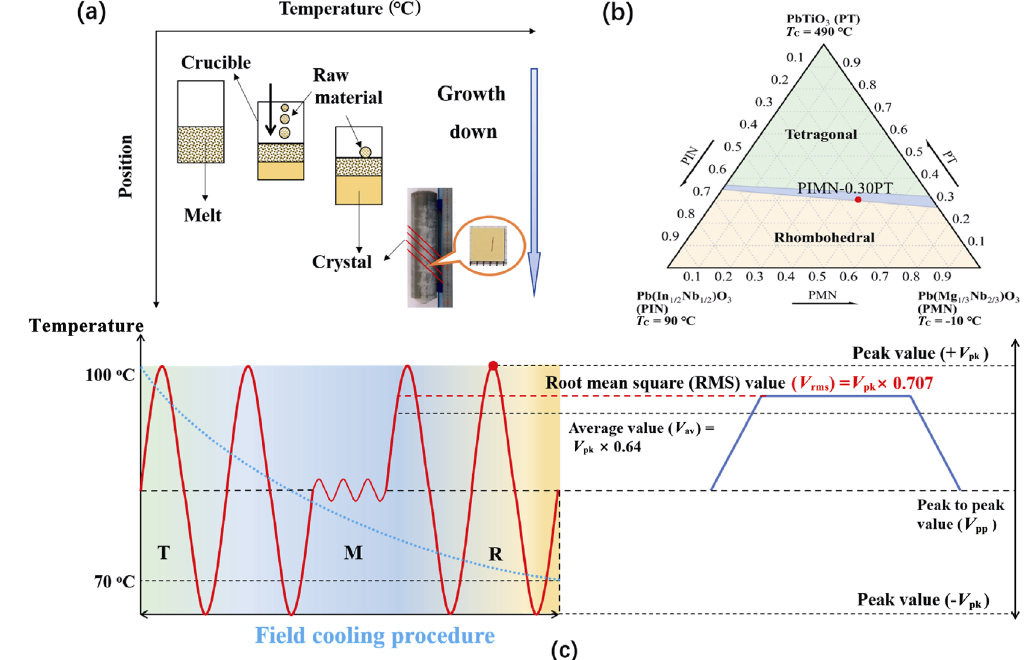
Fig. 1 PIMN–0.30PT SCs manufactured by (a) CF BM method, possessing multi-phase structure located in morphotropic phase boundary (MPB) region nearby R phase, are illustrated in (b) ternary phase diagram [15]. The entire FC ACP system of the PIMN–0.30PT SCs, through (c) phase transition path of T → M → R during cooling, was performed in air